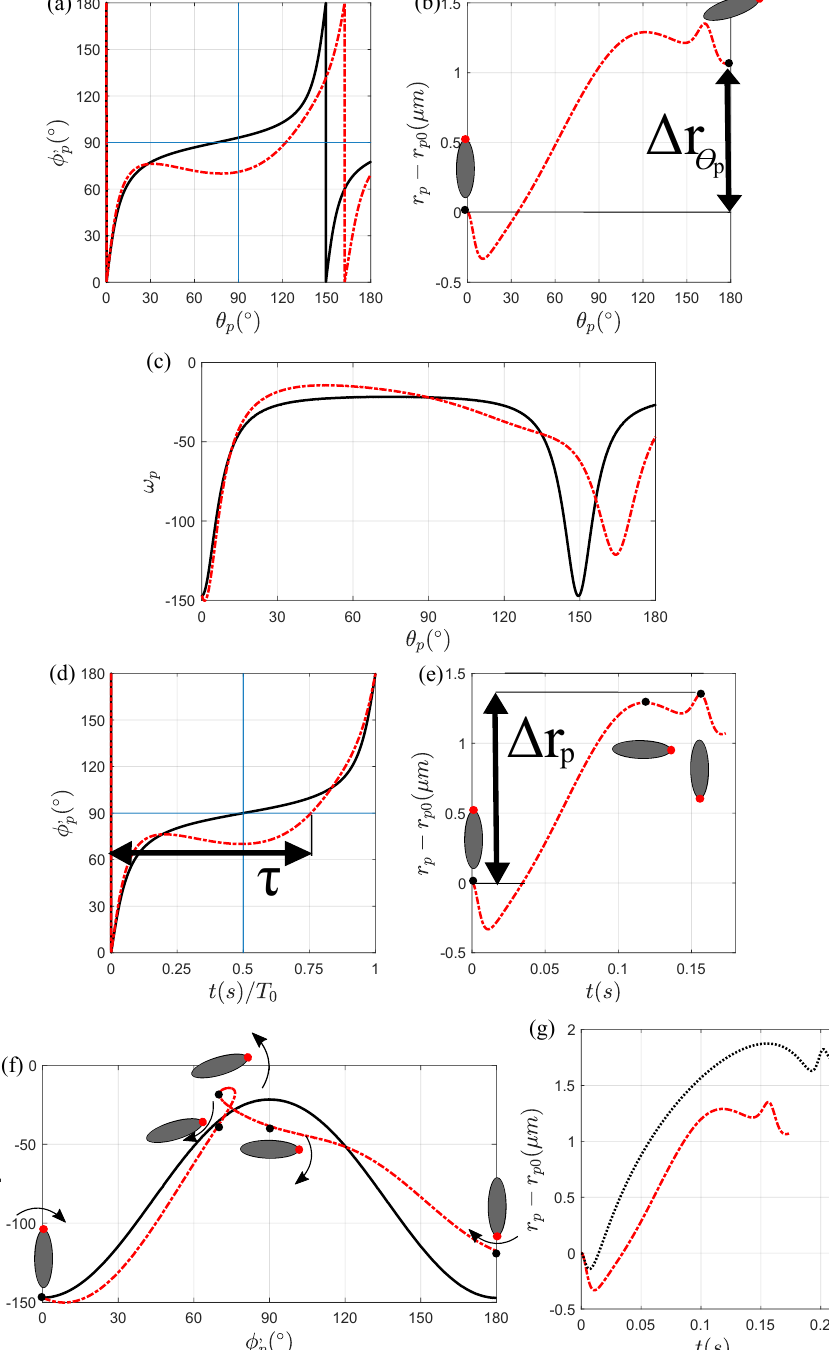
Figure 2. Particle dynamic and transportation comparison between H 0 = 0 A/m (solid black line), and H 0 = 3000 A/m applied at α = 0 ◦ (dot-dash red line) for ( a ) the particle’s rotation, ( b ) the radial migration, and ( c ) the angular velocity in terms of θ p ; ( d ) the particle’s rotation, ( e ) the radial migration, ( f ) the angular velocity in terms of time t , and ( g ) comparison between the particle-wall distances in a straight channel (dot black line) and in a curved channel (dot-dash red